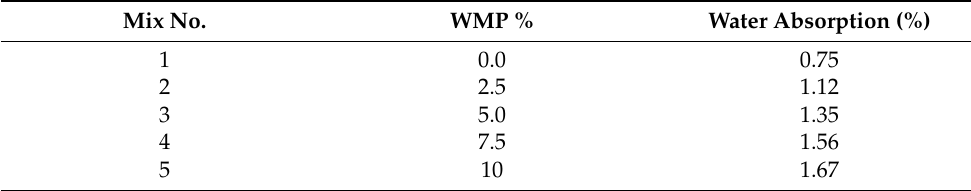
Table 6. Results of water absorption tests.